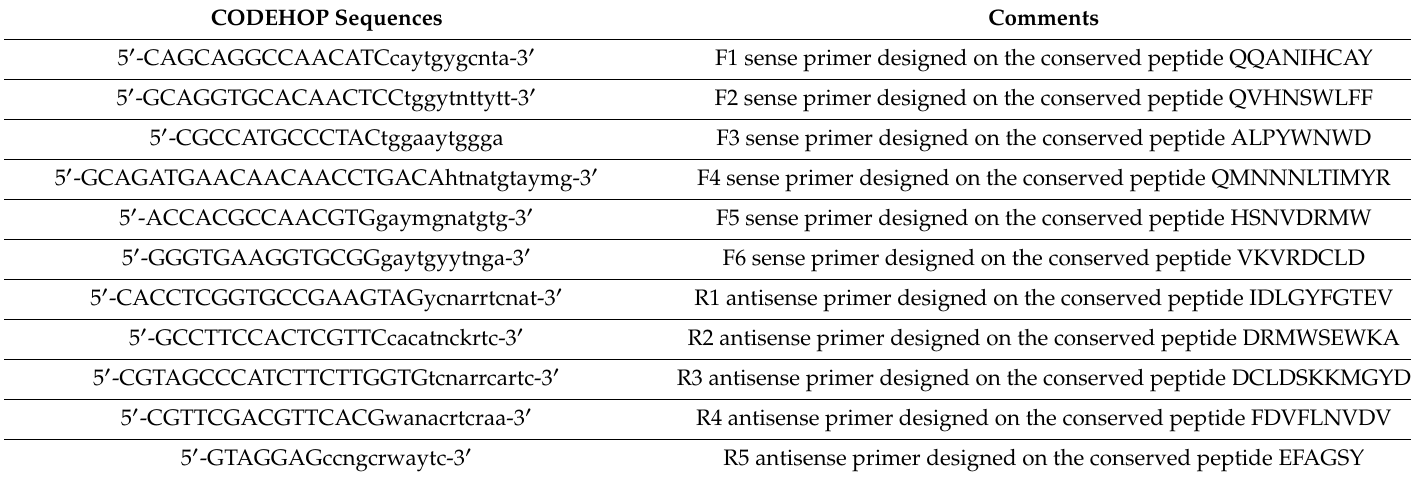
Table 1. Oligonucleotides used in the CODEHOP